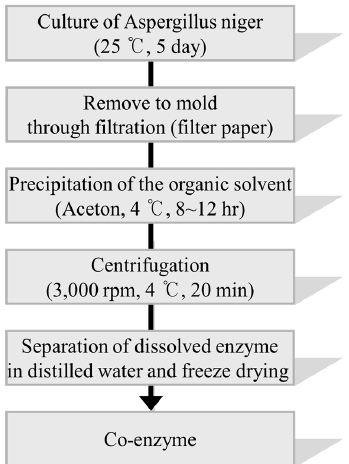
Figure 5. The flowchart of method to obtain the crude enzyme from Aspergillus niger .